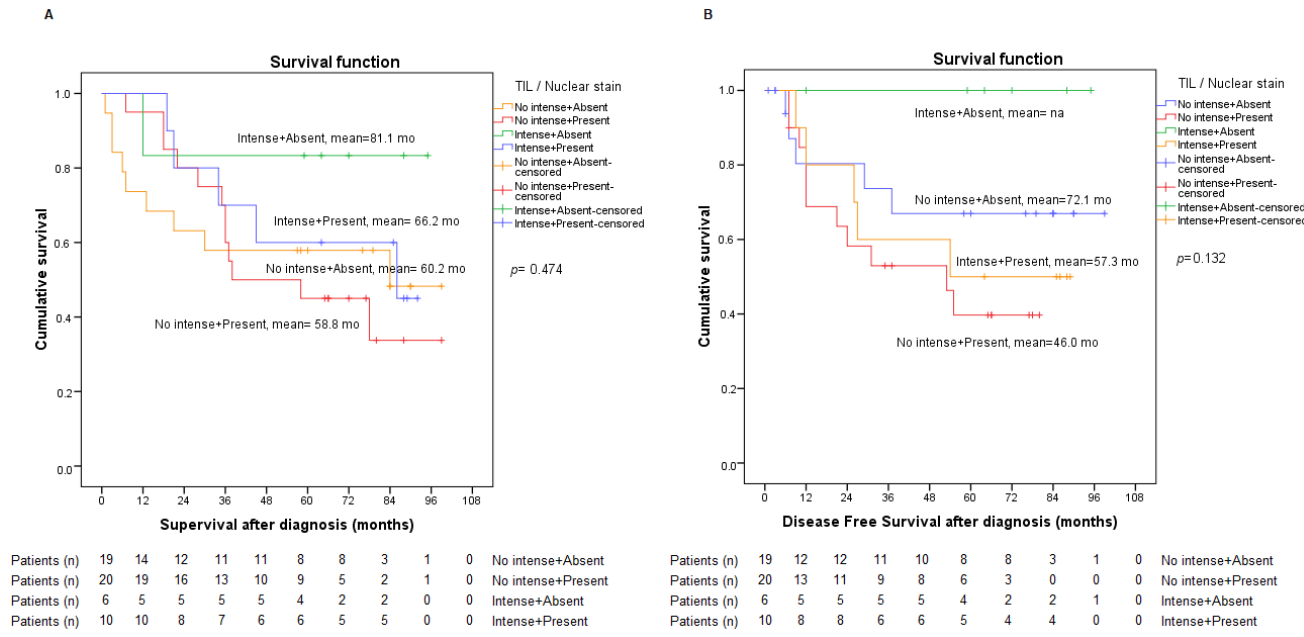
Figure 7. Analysis of overall survival ( A ) and disease-free survival ( B ) according to intense or non-intense TIL and absent or present TGF- β nuclear staining.